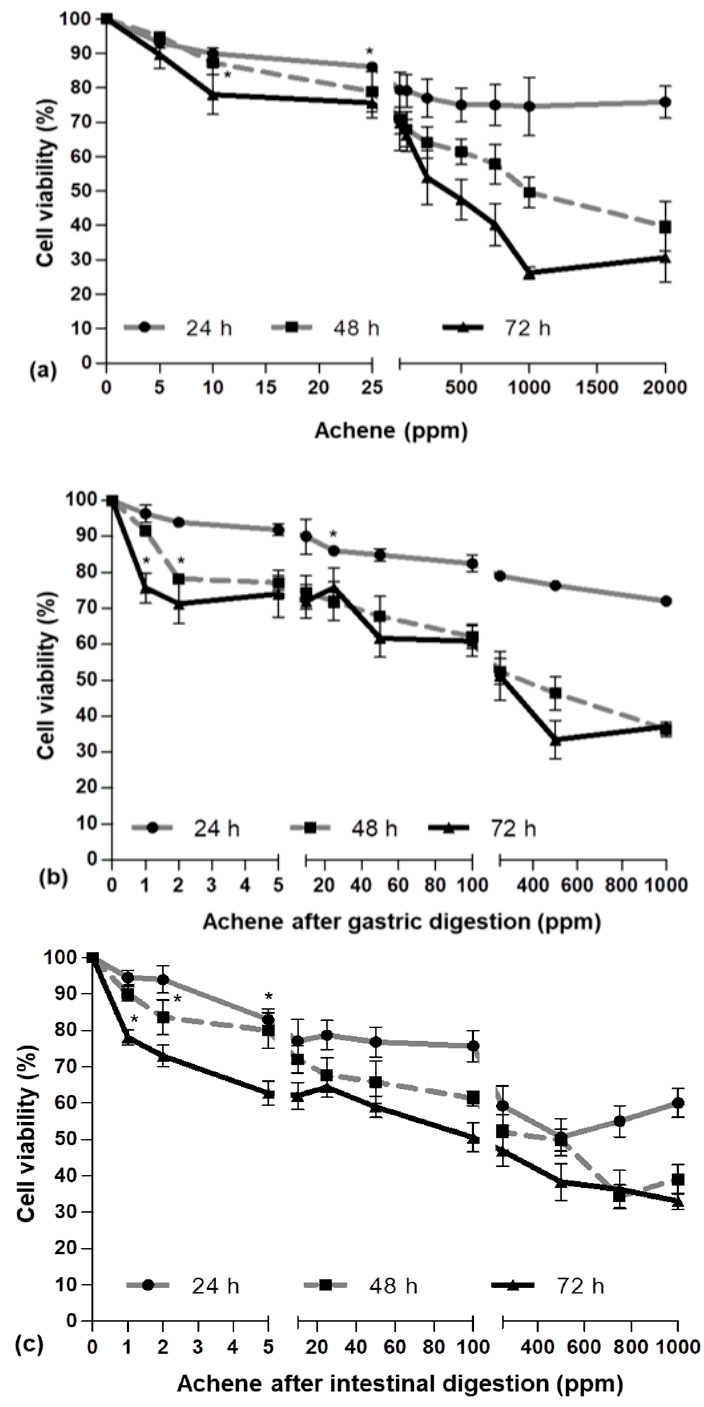
Figure 3. Viability of HepG2 determined by the MTT assay after incubation with different concentrations of ( a ) achene; ( b ) achene after gastric digestion; ( c ) achene after intestinal digestion. Values are expressed as the mean ± SD of three independent experiments ( n = 3). * Indicates the concentrations from which significant differences ( p < 0.05) were observed compared to the control.